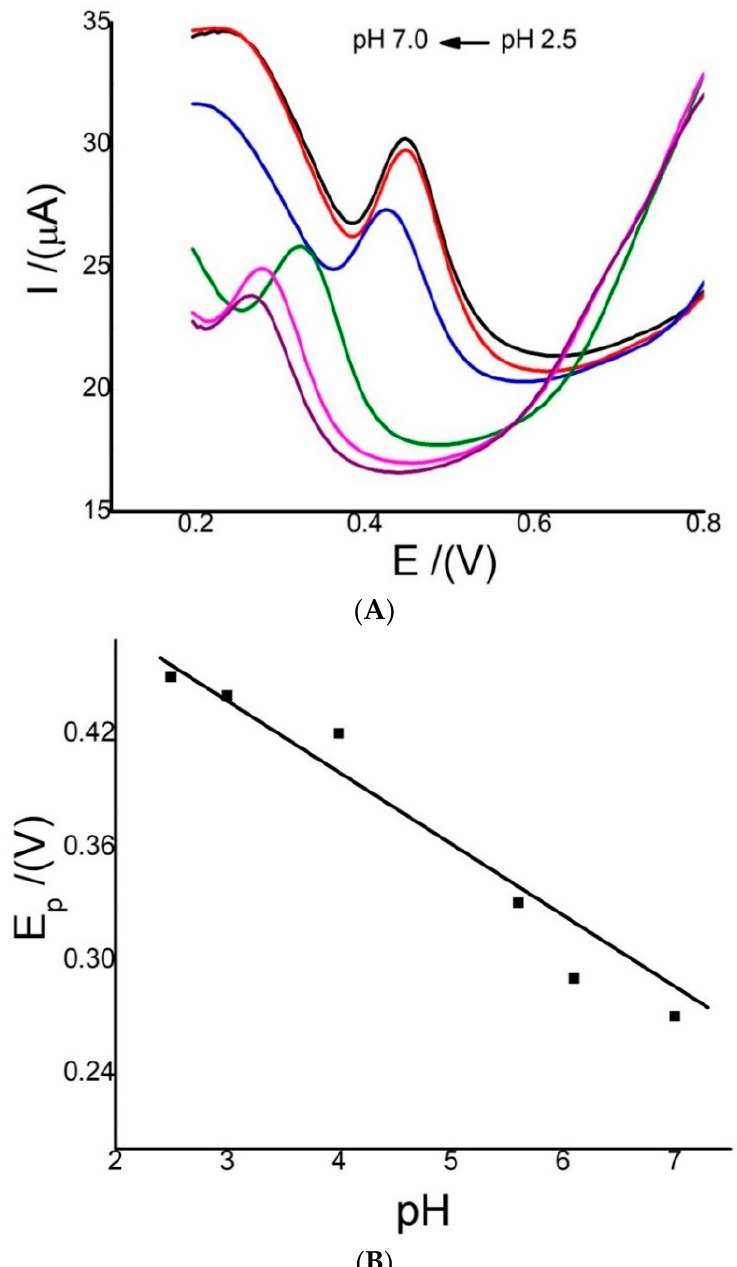
Figure 4. ( A ) SWVs of 0.12 mmol/L MR at pH values of 2.5 (black line), 3.0 (red line), 4.0 (blue line), 5.5 (green line), 6.0 (fuchsia line), and 7.0 (violet line); and ( B ) the effect of pH on E p (V) using Ch- G/GCE. Conditions: similar to those in Figure